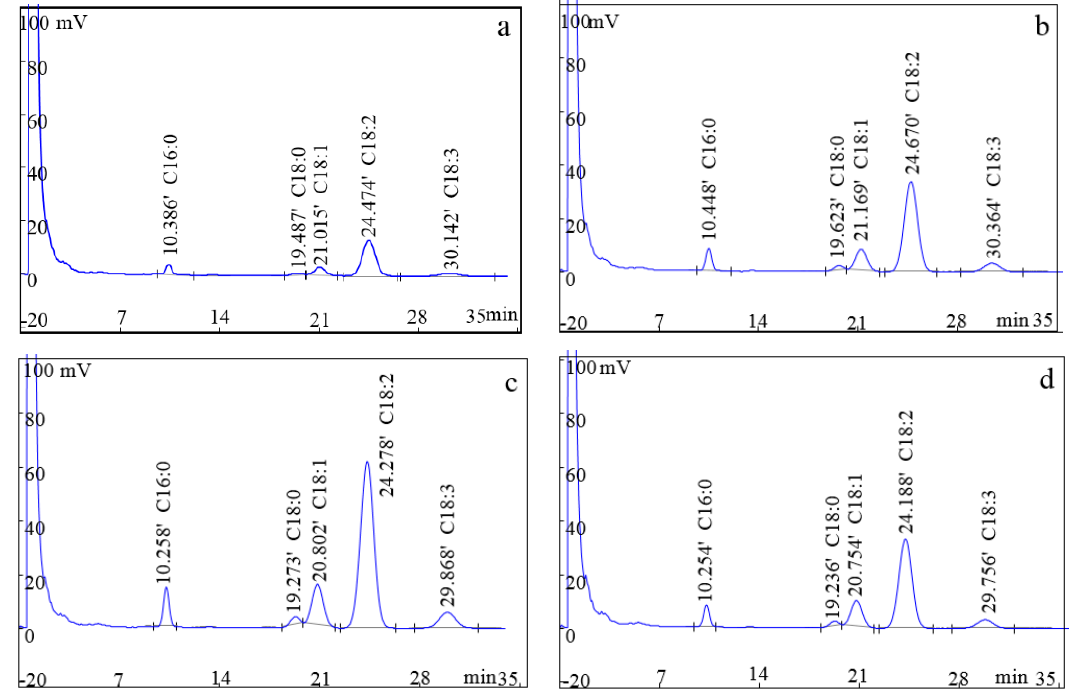
Figure 5. Fatty acid profiles of walnut kernels: ( a ) prior to frozen storage; ( b ) fresh kernel after 8-m frozen storage; ( c ) walnut with shell after 8-m frozen storage; ( d ) walnut with green husk after 8-m frozen